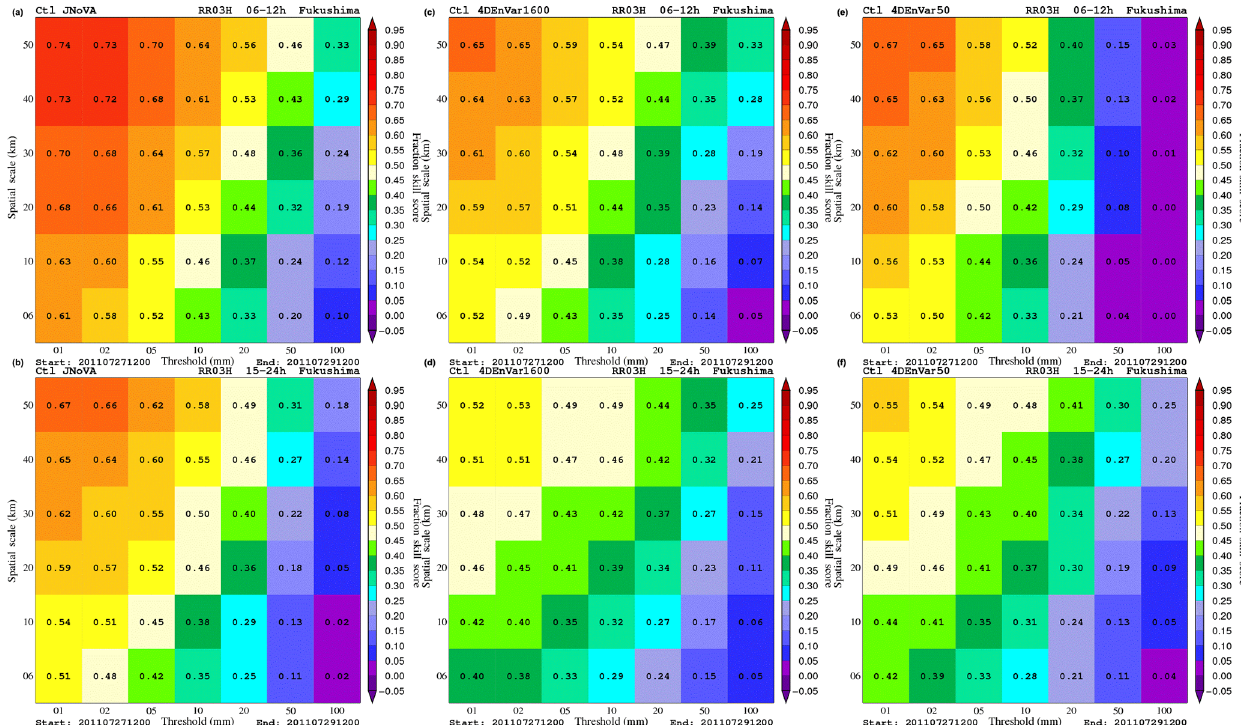
Figure 1. Fraction skill scores of 3h precipitation at Niigata–Fukushima from deterministic forecasts initialized by analyses from JNoVA (a, b) and 4D-EnVar-NHM using 1600 (c, d) and 50 members (e, f) . These scores are averaged over the period from 21:00JST on 24 July to 21:00JST on 29 July 2011. To obtain robust statistics, precipitation is aggregated over the first 12h forecasts (valid between 3 and 12h forecast) and the next 12h forecasts (valid between 12 and 24h forecasts) as shown in the top and bottom rows, respectively. Note that the first 3h precipitation is discarded due to the spin-up